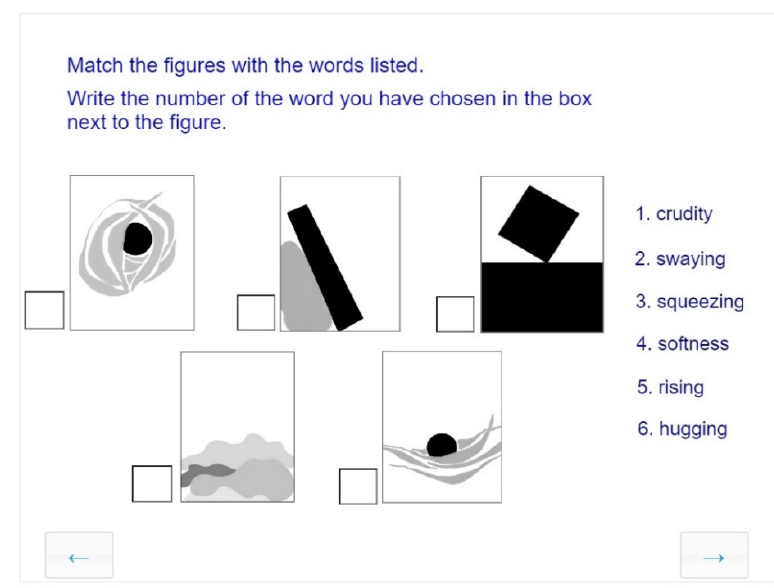
Figure 9. Example from a series of tasks designed to assess the abstraction subskill. Modality Change